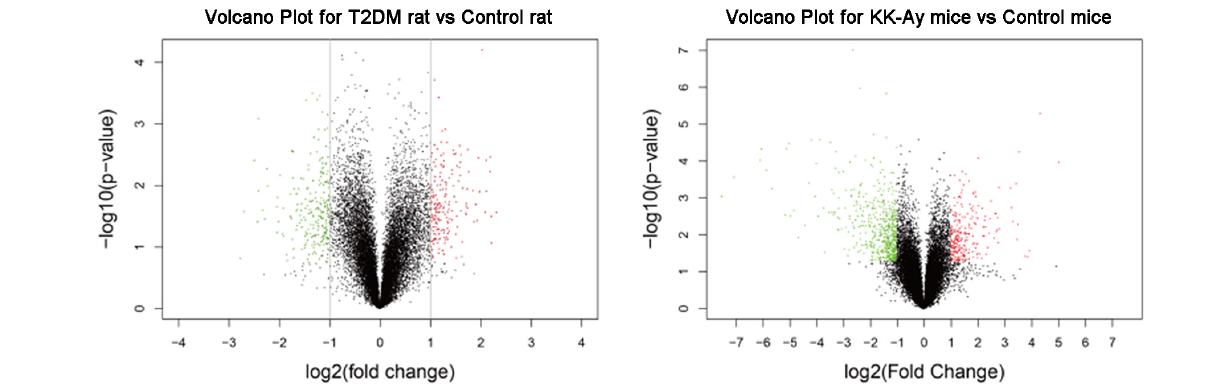
FIGURE 6 | Analyses of differentially expressed genes in kidneys from the T2DM animal models. Volcano plots of differentially expressed genes in the renal tissues from T2DM rats (left) and KK-Ay mice (right) are shown. The fold changes are represented in log2 scale as depicted on the x-axis, whereas the − log10 P -value is depicted on the y-axis. Genes with greater statistical significance are highlighted in the plots. The red/green dots represent genes that show differential expression with fold changes > 2 (red) or < 0.5 (green) and P -values < 0.05 between the T2DM renal tissues and normal control renal